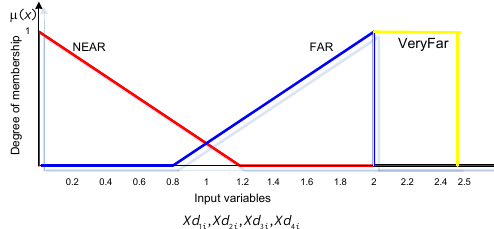
Fig. 9. The membership functions for input variables